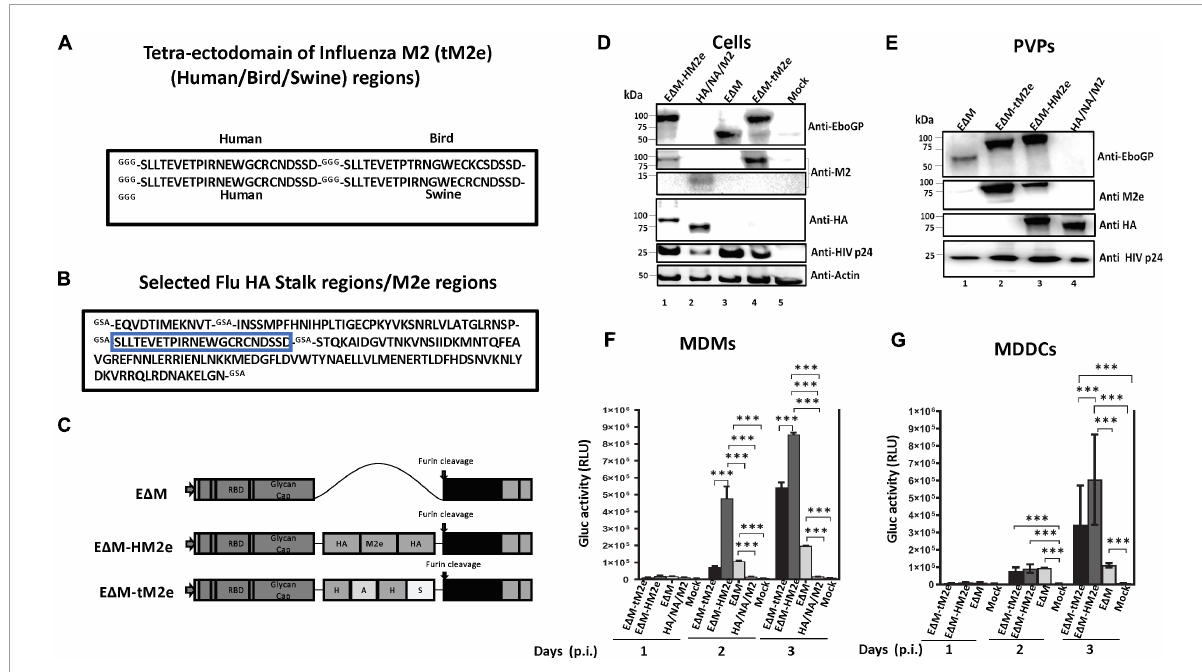
FIGURE1 The construction, expression, and cell entry ability of E (cid:49) M-tM2e or E (cid:49) M-HM2e. (A) Amino acid sequences of tM2e, including influenza virus M2e consensus from human, swine, and bird strains. (B) Amino acid sequence of HM2e, including influenza virus HA stalk and M2e from human strain. (C) E (cid:49) M plasmid containing EboGP gene with MLD deletion (aa 305–485) and E (cid:49) M-HM2e or E (cid:49) M-tM2e plasmids. (D,E) 293T cells were co-transfected (cid:49) 8.2, (cid:49) RI/ (cid:49) E/Gluc+ with E (cid:49) M-tM2e and E (cid:49) M-HM2e or HA, NA, and M2 plasmids. WB was used to detect the expression of M2e, HA, EboGP, and HIV P24 in cells and PVPs. (F,G) Human PBMC-derived macrophages (MDMs) and dendritic cells (MDDCs) were infected with the E (cid:49) M-HM2e, E (cid:49) M-tM2e, E (cid:49) M, and HA/NA/M2-PVPs. The supernatants were collected at different time points after infection and subjected to a GLuc activity assay. Error bars represent variation between duplicate samples, and the data are representative of results obtained in three independent experiments. Statistical significance was determined using an unpaired t -test, and significant p -values were represented with asterisks ∗∗∗ ≤ 0.001. No significance (ns) was not